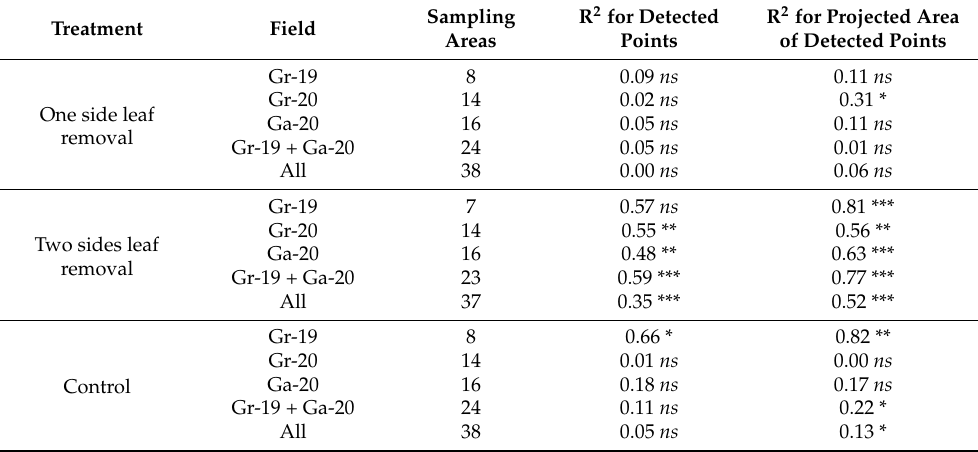
Table 1. Correlation coefficients between harvest weight and the studied variables for the different leaf removal treatments and fields.